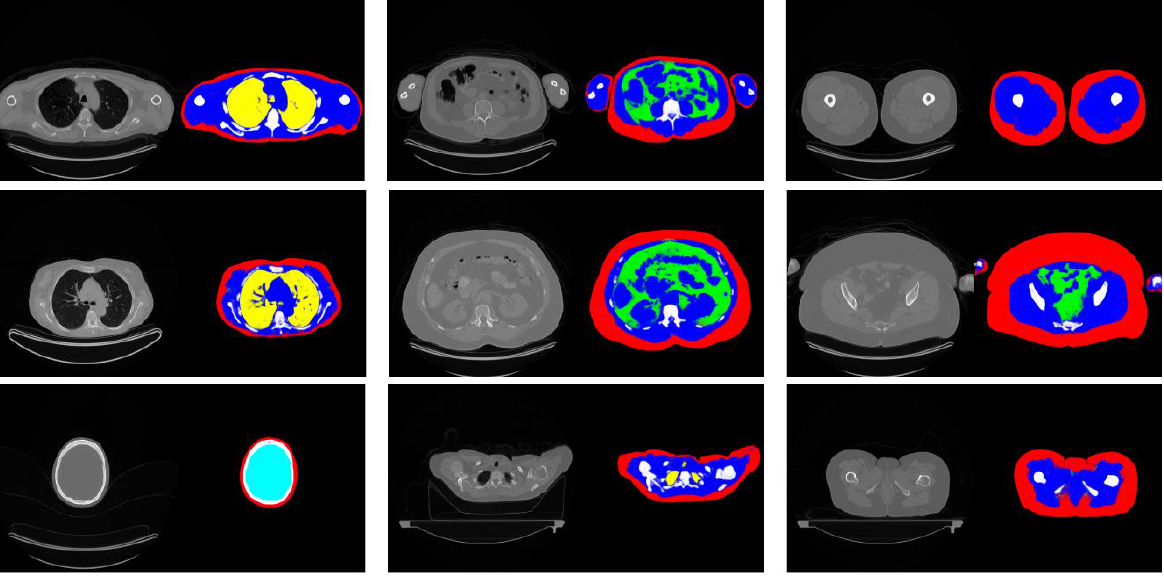
Figure 3. Pairs of CT images outside of the training set and sematic segmentation maps generated with deep convolutional neural network. The background, lungs, bones, brain, subcutaneous and visceral adipose tissue, and other soft tissues were labelled in black, yellow, white), cyan, red, green, and blue,